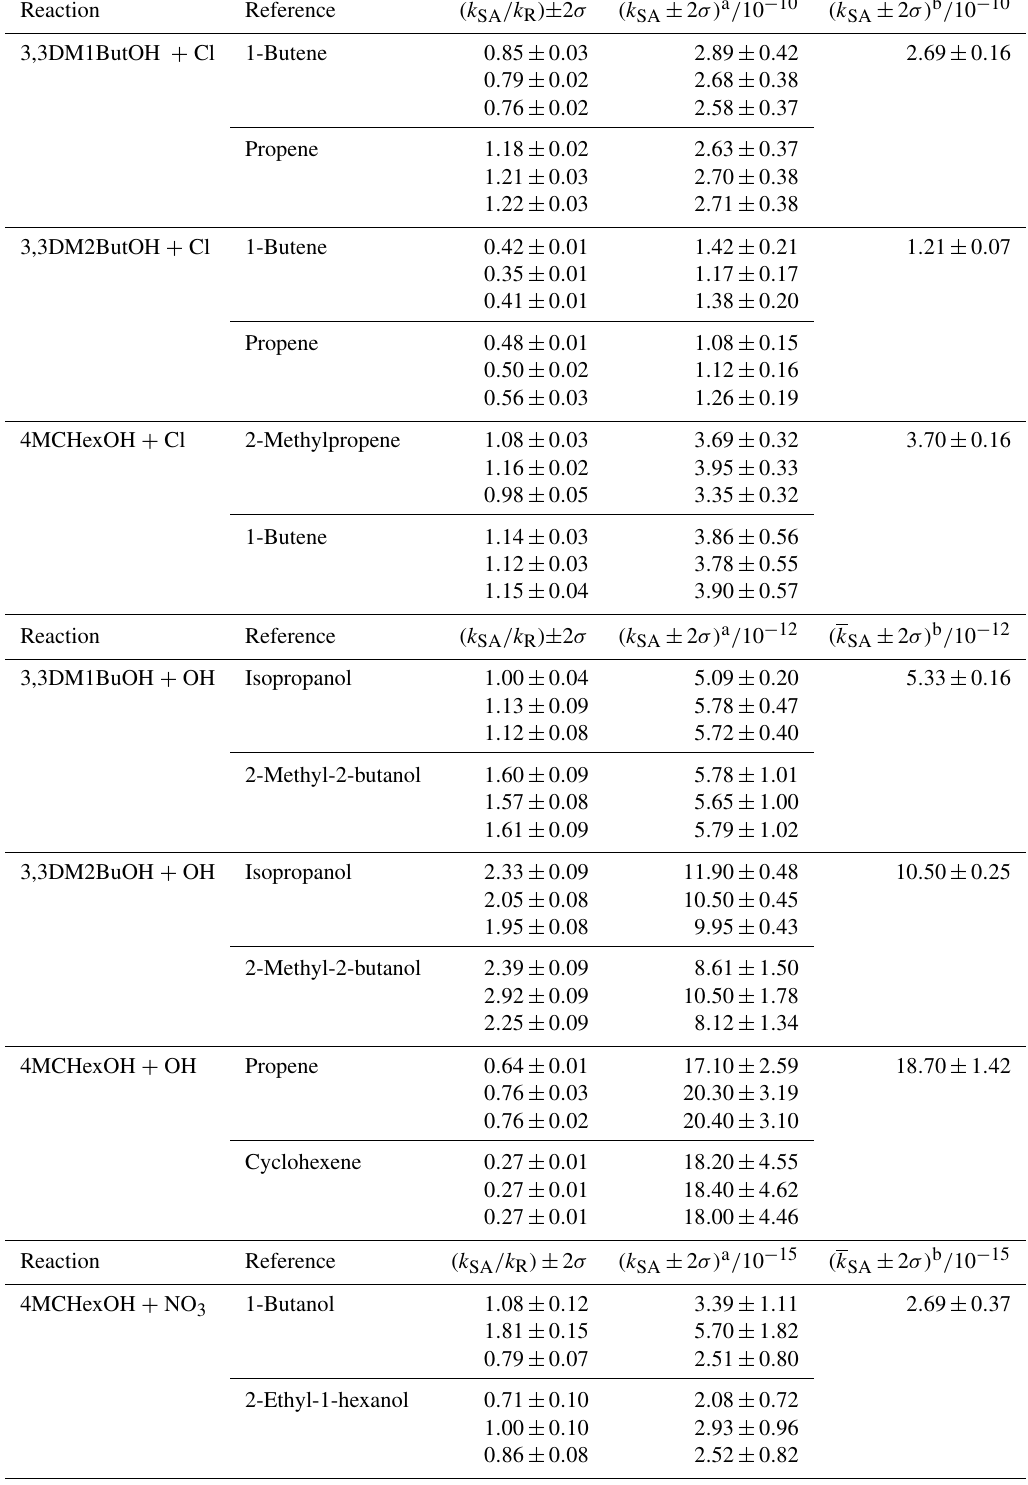
a The uncertainties for rate coefficients of SAs ( σ SA ) were calculated from the uncertainty of the slope of plots ( σ slope ) and the uncertainty of the reference ( σ kR ) using the propagation of uncertainties. b The weighted average according to the equation ( w 1 k 1 + w 2 k 2 + ...) / ( w 1 + w 2 ...); ( w i = 1 /σ 2 ι ). The uncertainty of the weighted average ( σ ) was given by ( 1 /w 1 + 1 /w 2 + ...) − 0 . 5